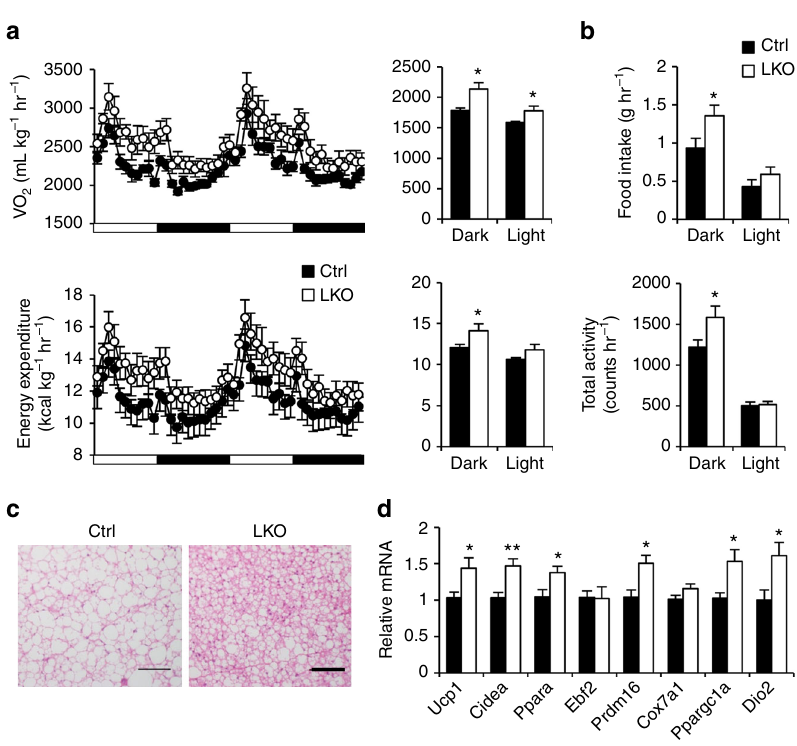
Fig. 5 Hepatic ablation of Blnc1 stimulates thermogenesis and energy expenditure. a , b VO 2 and energy expenditure ( a ), food intake and total activity ( b ) in ctrl ( fi lled, n = 8) and LKO (open, n = 8) mice fed HFD for 15 weeks. Data in ( a ) and ( b ) represent mean ± SEM. * p < 0.05; ctrl vs. LKO, two-tailed unpaired Student ’ s t -test. c H&E staining of BAT section from HFD-fed mice. Scale bar = 100 μ m . d qPCR analysis of brown fat gene expression in HFD-fed ctrl ( fi lled, n = 9) and LKO (open, n = 9) mice. Data represent mean ± SEM. * p < 0.05, ** p < 0.01; ctrl vs. LKO, two-tailed unpaired Student ’ s t